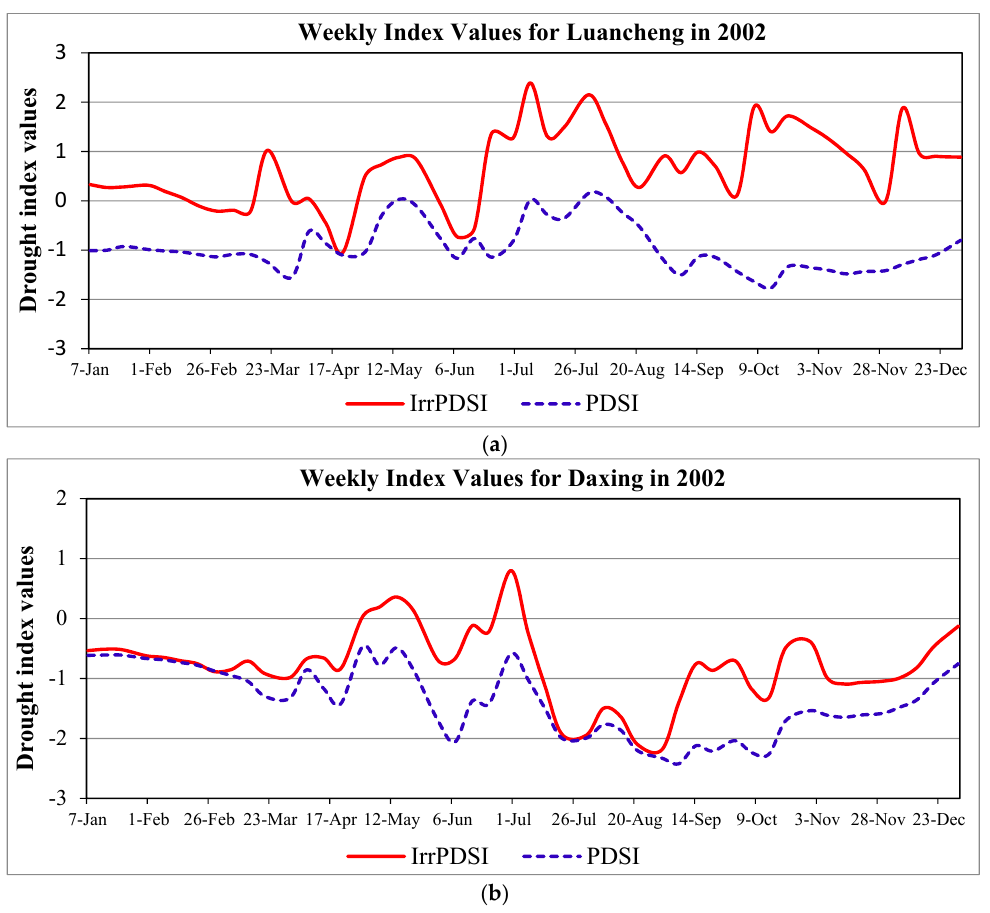
Figure 8. Time series plot of the two PDSIs at ( a ) Luancheng and ( b ) Daxing in 2002.